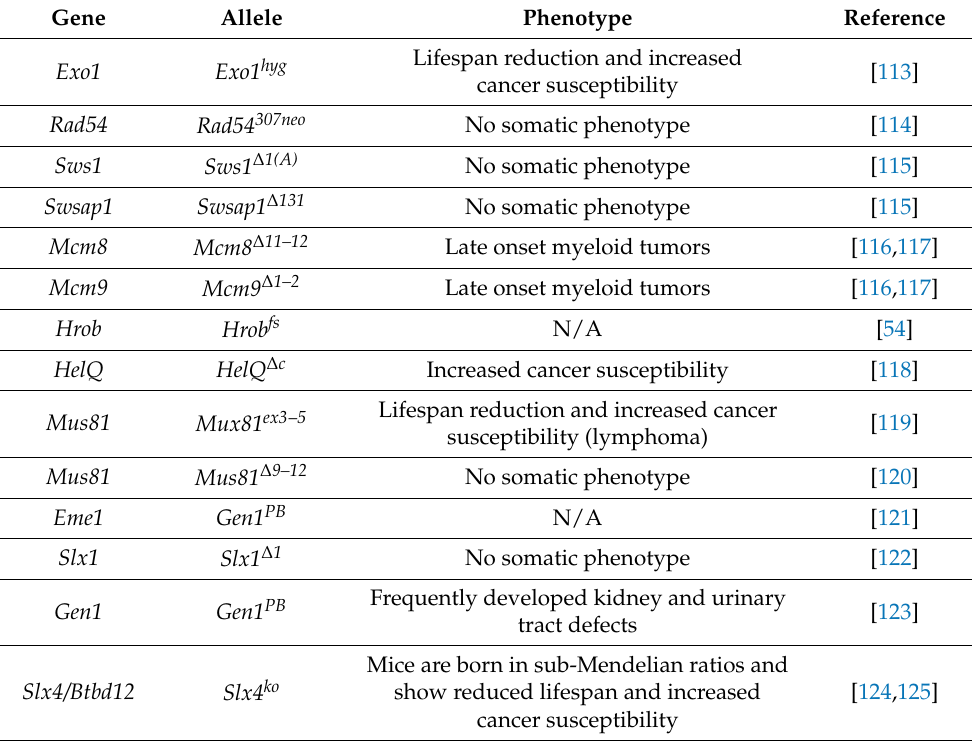
Table 2. Nonembryonic lethal mouse models of complete or severe loss of function of HR genes. Phenotype: when the mutant allele is in homozygosis. N/A: not